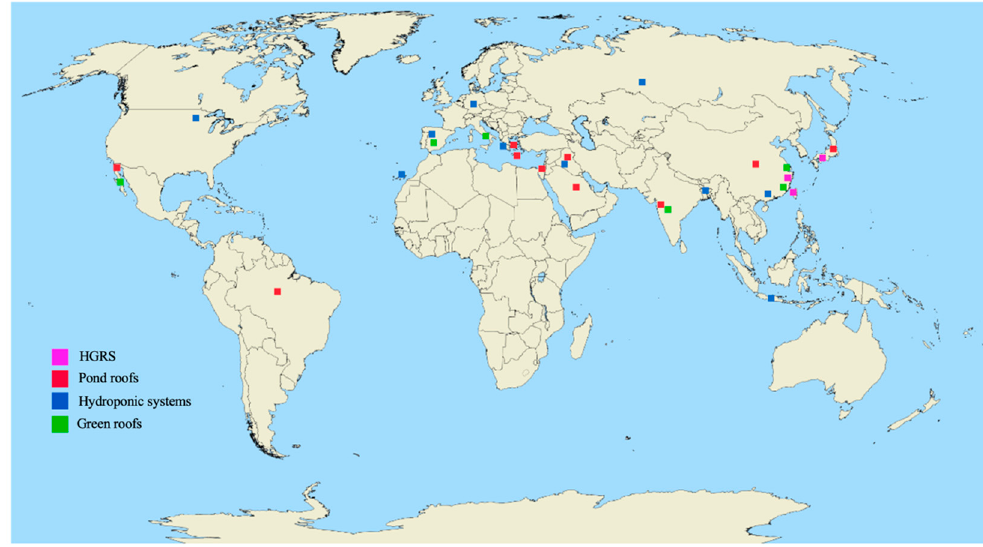
Figure 1. Geographic individuation of analyzed studies on hydroponic green roof systems [12,18–20], pond roofs [6,22–27], hydroponic systems [17,28–31], green roofs [4–6,8,23,32].